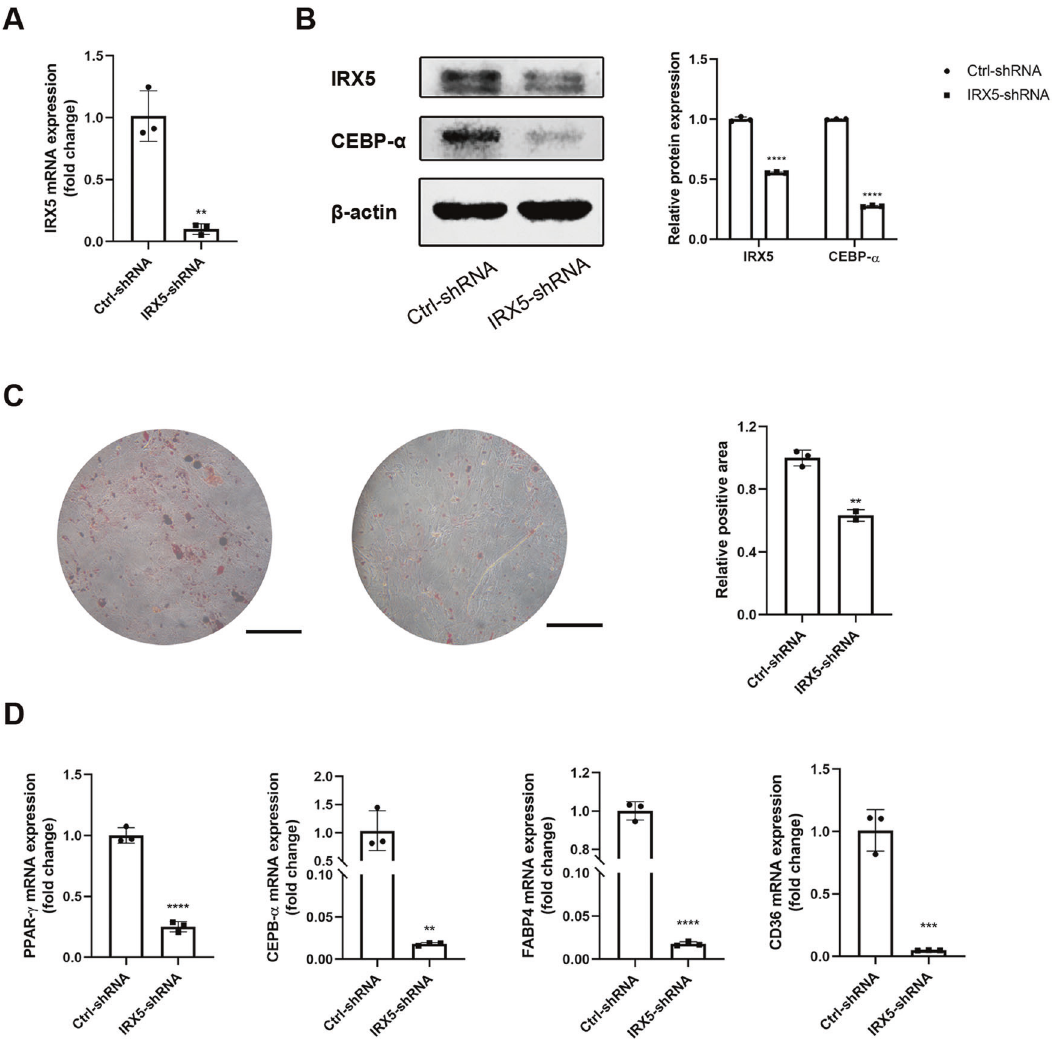
Fig. 3 Effect of IRX5 knockdown on the adipogenic differentiation of hMSCs. A , B IRX5 knockdown ef fi ciency were veri fi ed by qRT-PCR ( A ) and western blot ( B ). B IRX5 and CEBP- α protein expression. C Oil red O staining analysis of lipid droplets at D16 after adipogenic differentiation. D qRT-PCR analysis of PPAR- γ , CEBP- α , CD36 and FABP4 at D8 after adipogenic differentiation. Scale bar, 500 μ m. Results are shown as mean ± SD. n = 3. * Indicates a signi fi cant difference from the control group, * p < 0.05, ** p < 0.01, *** p < 0.001, **** p <